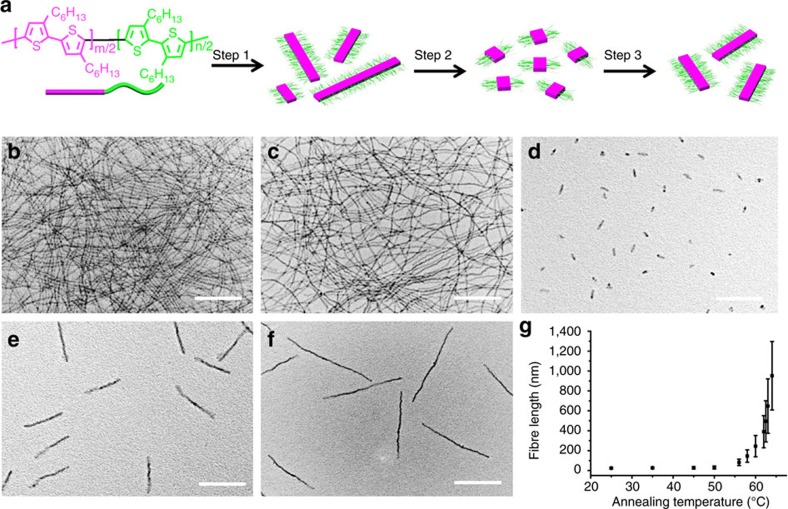
Fibres from rrP3HT-b-rsP3HT.(a) Chemical structure of rrP3HT-b-rsP3HT diblock copolymer and the schematic illustration of Step 1, self-assembly of rrP3HT-b-rsP3HT to form fibres in anisole; Step 2, fragmentation of the fibres; and Step 3, thermal annealing to form uniform fibres. TEM images of the unfragmented fibres from (b) rrP3HT48-b-rsP3HT43 and (c) rrP3HT106-b-rsP3HT47, which were obtained by directly dispersing the polymer solid in anisole at 0.1 mg ml−1 at 80 °C for 1 h and then slowly cooling to 23 °C. Uniform fibres from rrP3HT106-b-rsP3HT47 prepared by subjecting anisole solutions of fibres (0.1 mg ml−1) to ultrasonication at 0 °C for 1 h, followed by thermal annealing at (d) 56.0 °C, (e) 62.5 °C, (f) 64.0 °C for 30 min and then slow (ca. 6 h) cooling to 23 °C. Scale bars, 500 nm. (g) Plot of the Ln of the rrP3HT106-b-rsP3HT47 fibres versus self-seeding temperatures.